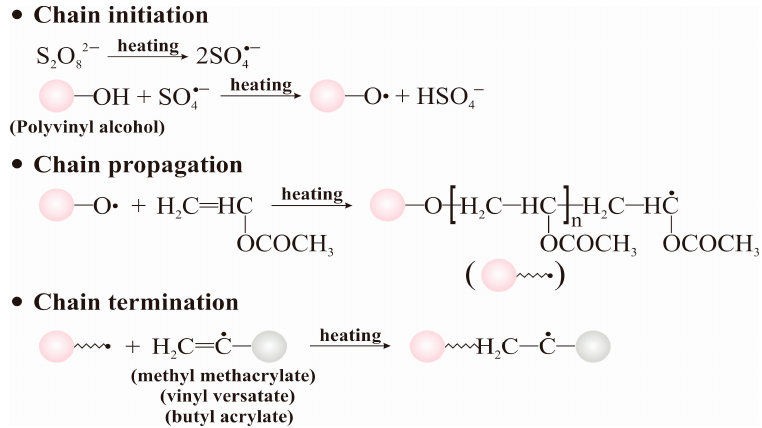
Figure 1. Th e diagram showing the working principle of vinyl acetate (VA) and polyvinyl alcohol (PVA).